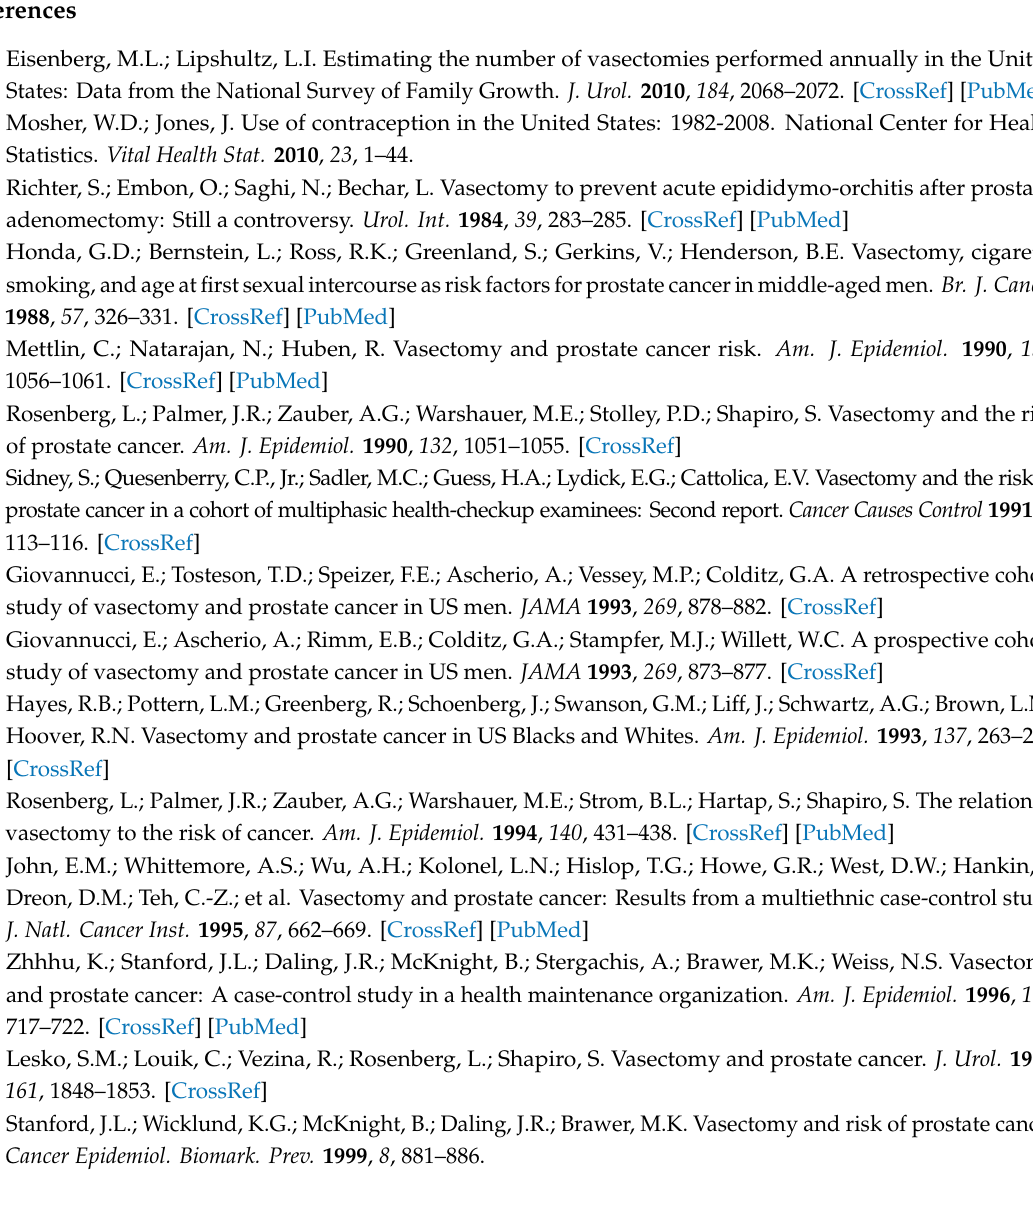
Figure S1: The status of vasectomy and relative risks for prostate cancer in US cohort / case-control studies., Figure S2: The whole Western blotting images for Figure 4A,B, Figure S3: E ff ect of ZKSCAN3 knockdown on colony formation, Table S1: Incidence of tumors in castrated TRAMP mice., Table S2: Vasectomy and radical prostatectomy